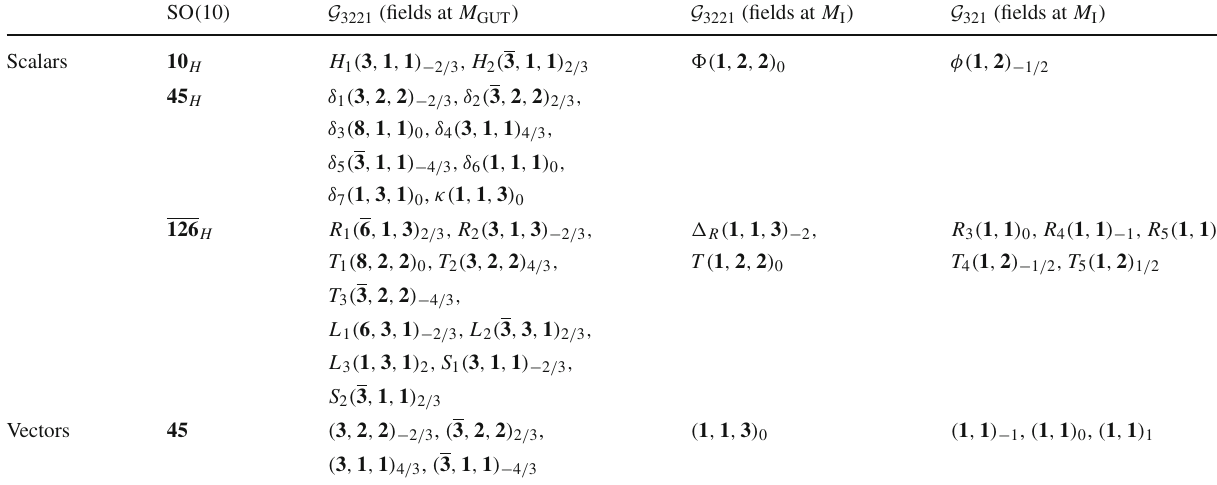
Table 7 Scalar and vector fields that have masses around M GUT and M I in the G 3221 model SO ( 10